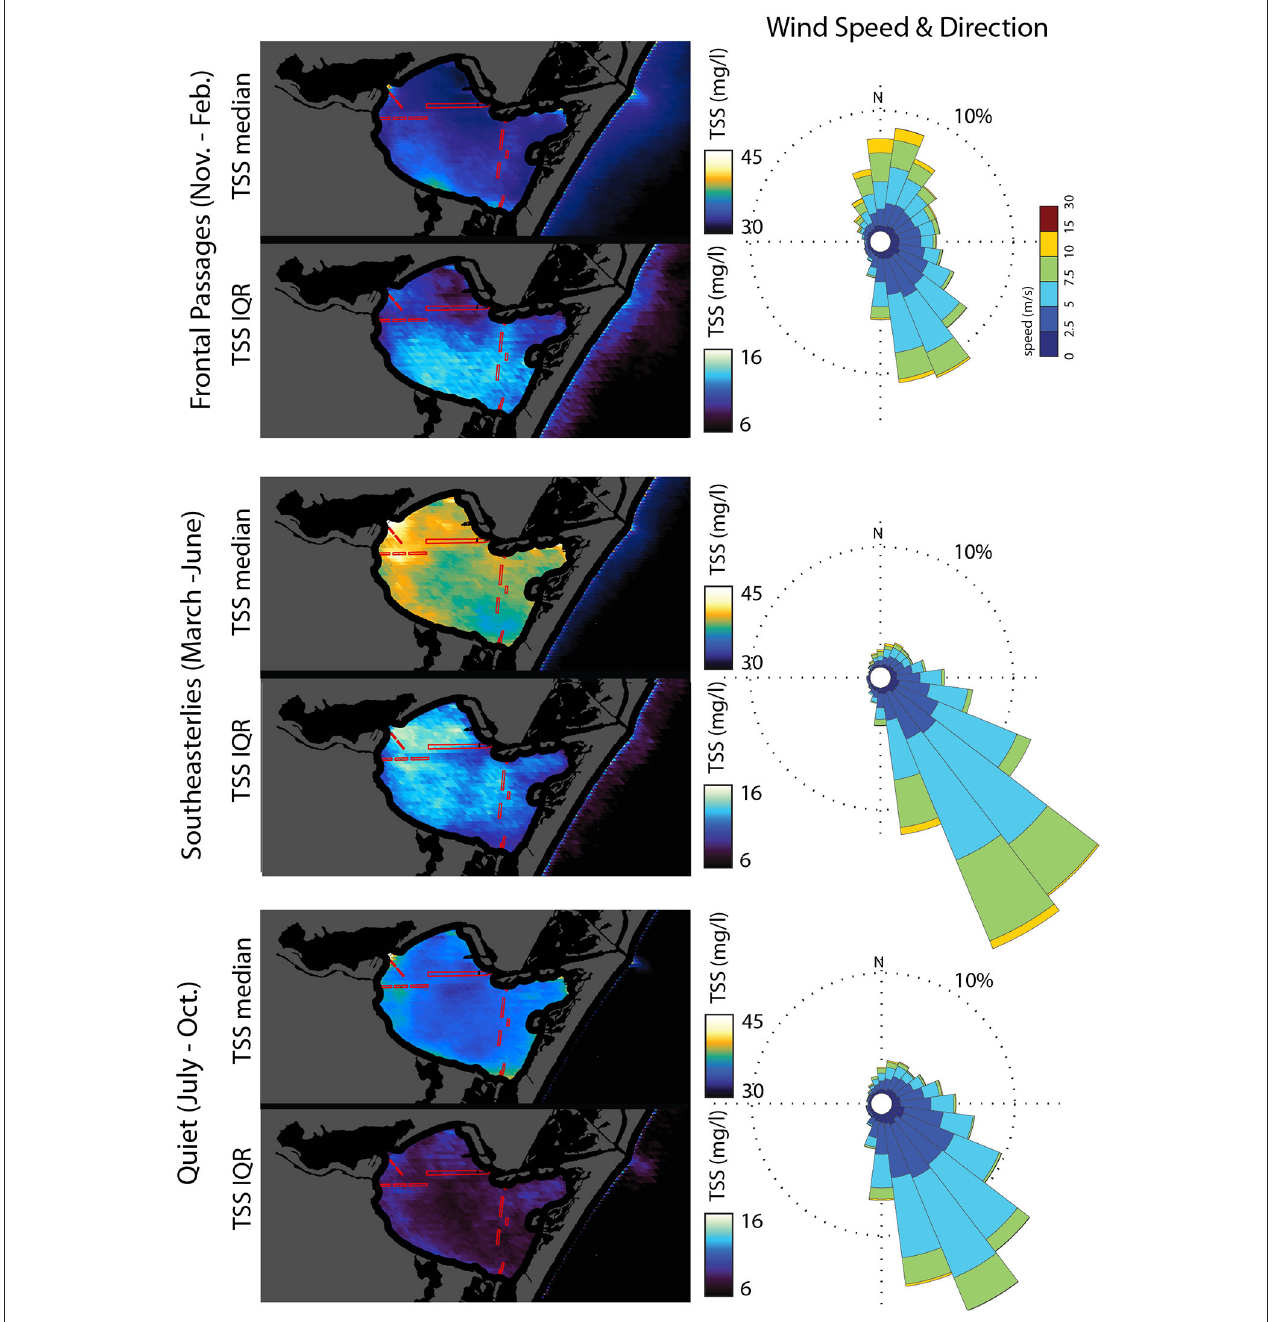
FIGURE 6 | Corpus Christi Bay TSS Median and IQR with corresponding wind rose for each wind regime. Red rectangular polygons are dredge spoil deposition sites.